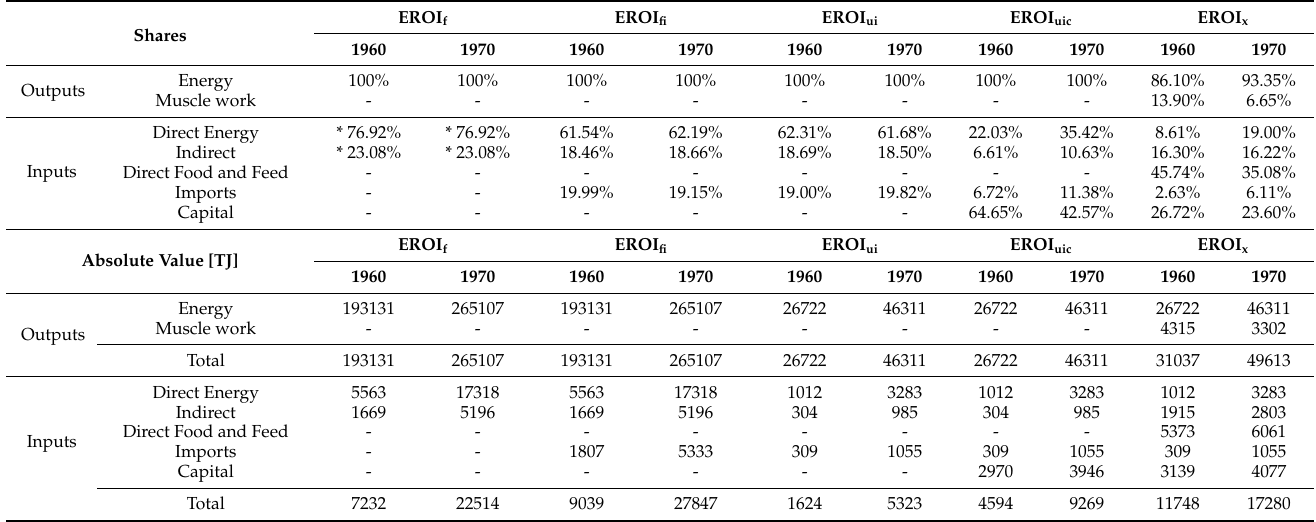
Table 3. The shares and absolute values of the inputs and outputs for each different EROI calculation (Authors’ own